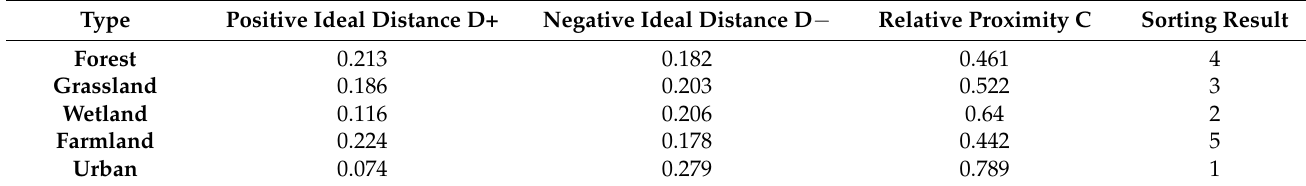
Table 7. Ranking of ecosystem type change results (county).